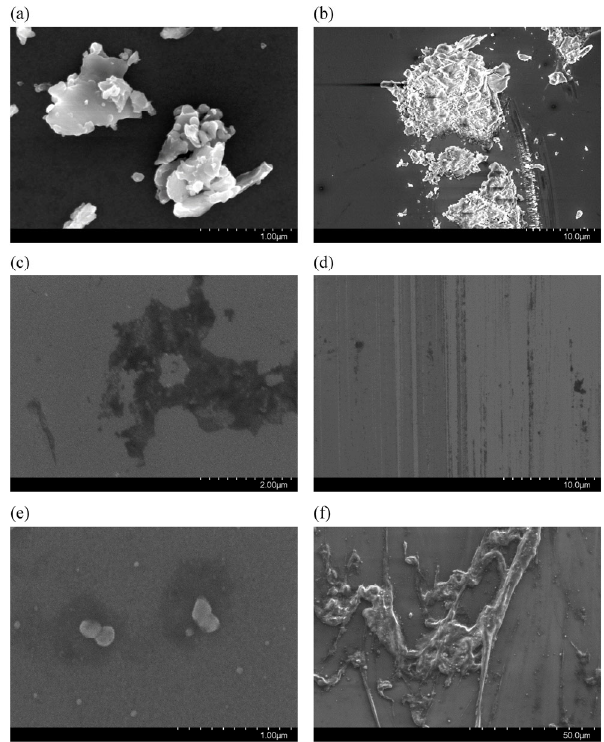
Fig. 14 Morphology of the wear debris of different polymer spheres. (a) PS; (b) PP; (c) PA 66; (d) POM; (e) PE; and (f) PTFE.